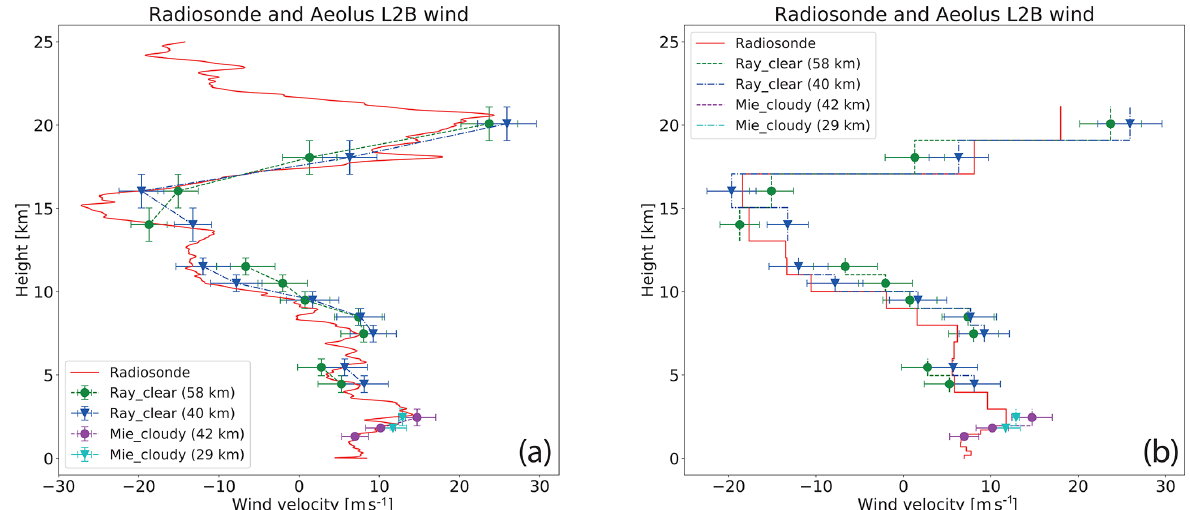
Figure 4. Wind velocity profiles measured by the radiosonde (red) with the two closest Aeolus Level 2B (L2B) Rayleigh clear (green and blue) and Mie cloudy (magenta and cyan) profiles on 29 November 2018. The radiosonde profile is shown with its highest resolution (a) and with an adjusted resolution to the Aeolus range bin width (b) . The radiosonde measurements are projected to the HLOS of